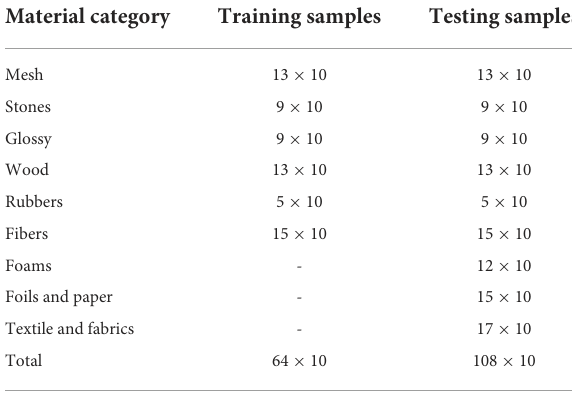
TABLE 1 The details of the dataset splits on